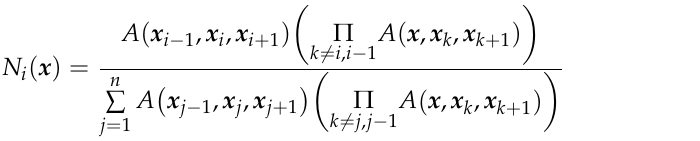
i using Wachspress